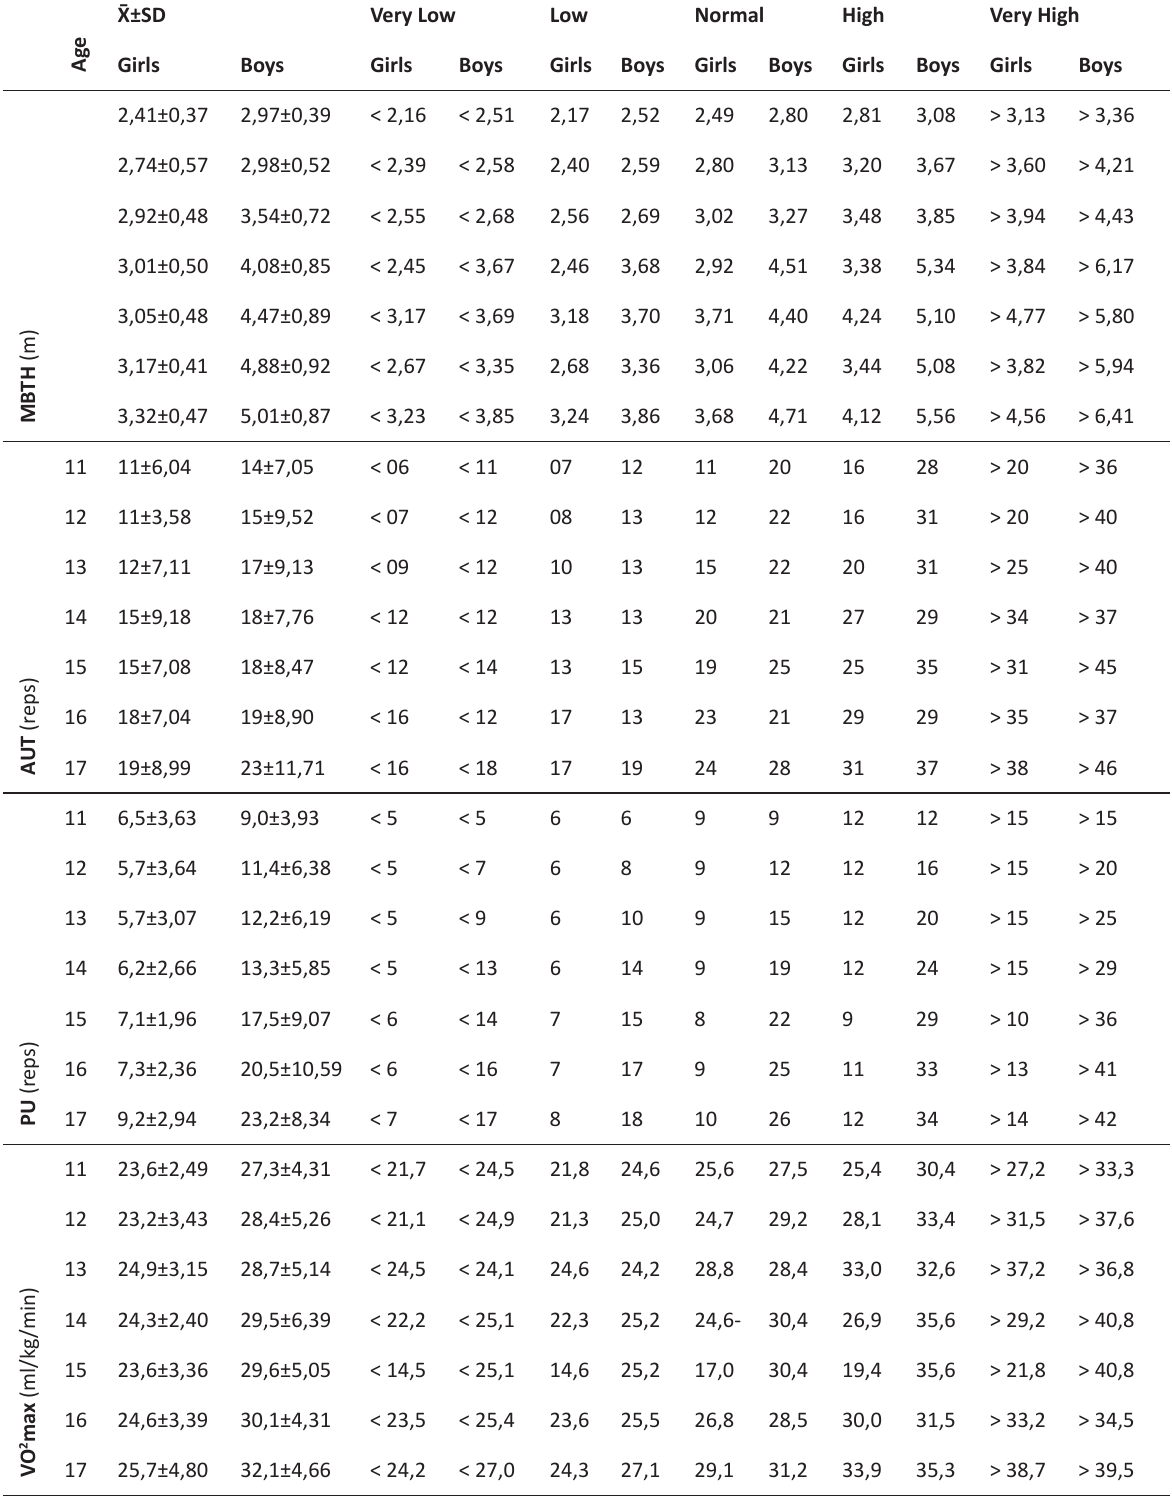
Table 4. Standing Medicine Ball Throw, Arch Up Test, Push-up, Maximum Oxygen Intake Normative Values X̄±SD Very Low Low Normal High Very e g A